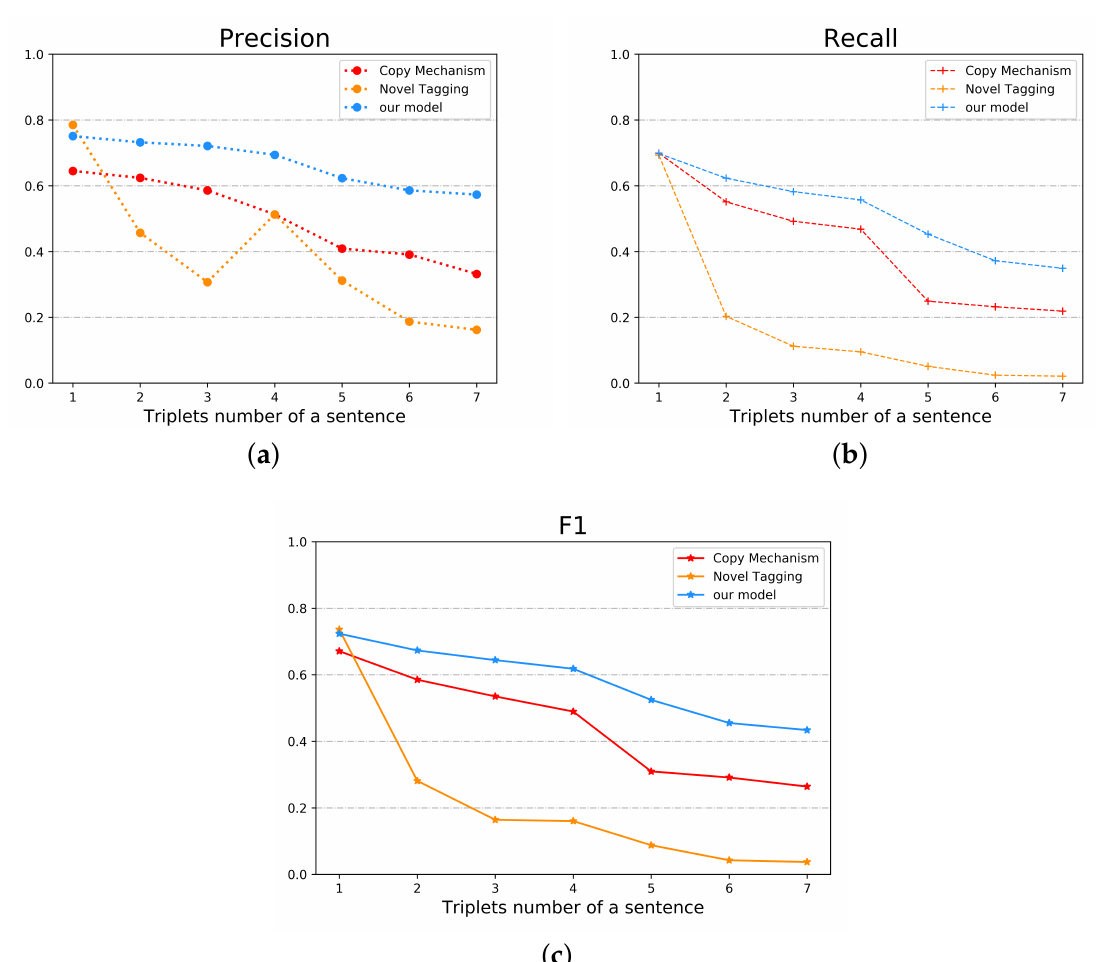
Figure 9. Comparison of results of our model and baselines on sentences that contains di ff erent number of triplets ( ≤ 7 ) . ( a ) The value of precision of di ff erent methods; ( b ) The value of recall of di ff erent methods; ( c ) The value of F1 of di ff erent methods.